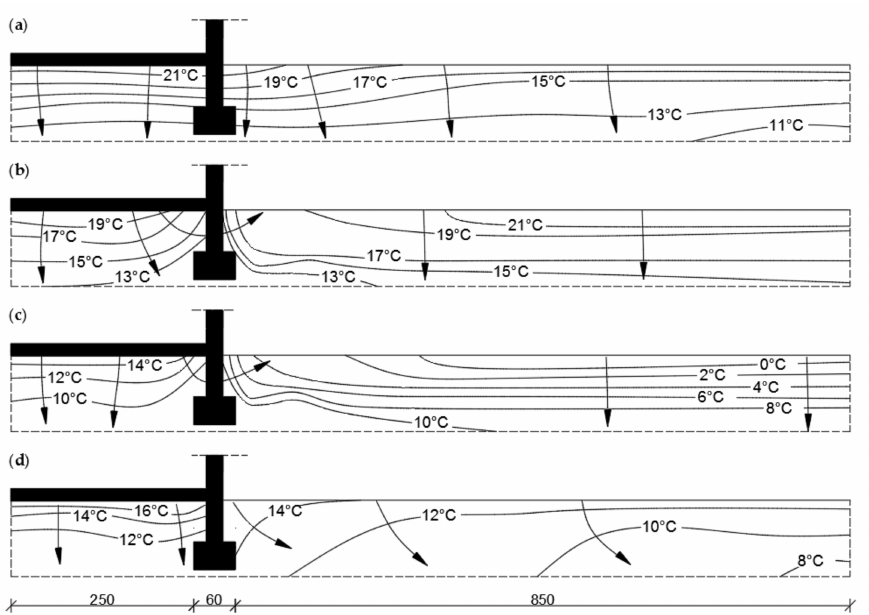
Figure 10. Soil temperature under and in the surroundings of the building and heat stream flow directions in ( a ) summer, ( b ) autumn, ( c ) winter, and ( d )